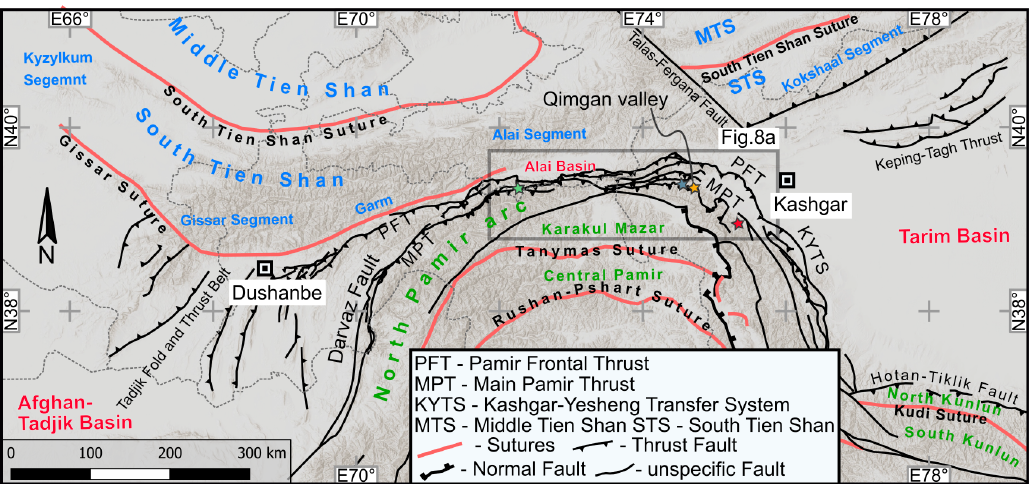
Figure 1. Overview map of the North Pamir and surroundings. The yellow star marks the position of the Qimgan valley, as noted. The meanings of the other star symbols are explained in Fig. 8. Map drawn after Konopelko et al. (2019), Li et al. (2020), and Henan Institute of Geological Survey